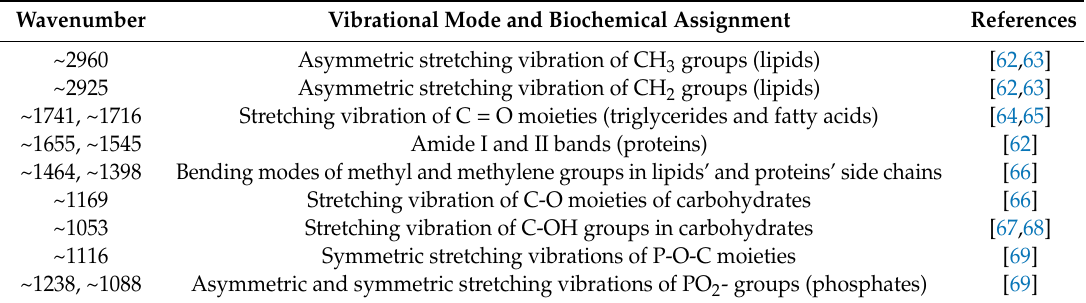
Table 3. Vibrational analysis of second derivative spectra of uFSH, rFSH and hMG samples. The wavenumbers of the most relevant biological absorptions are listed, together with the corresponding vibrational mode and biochemical